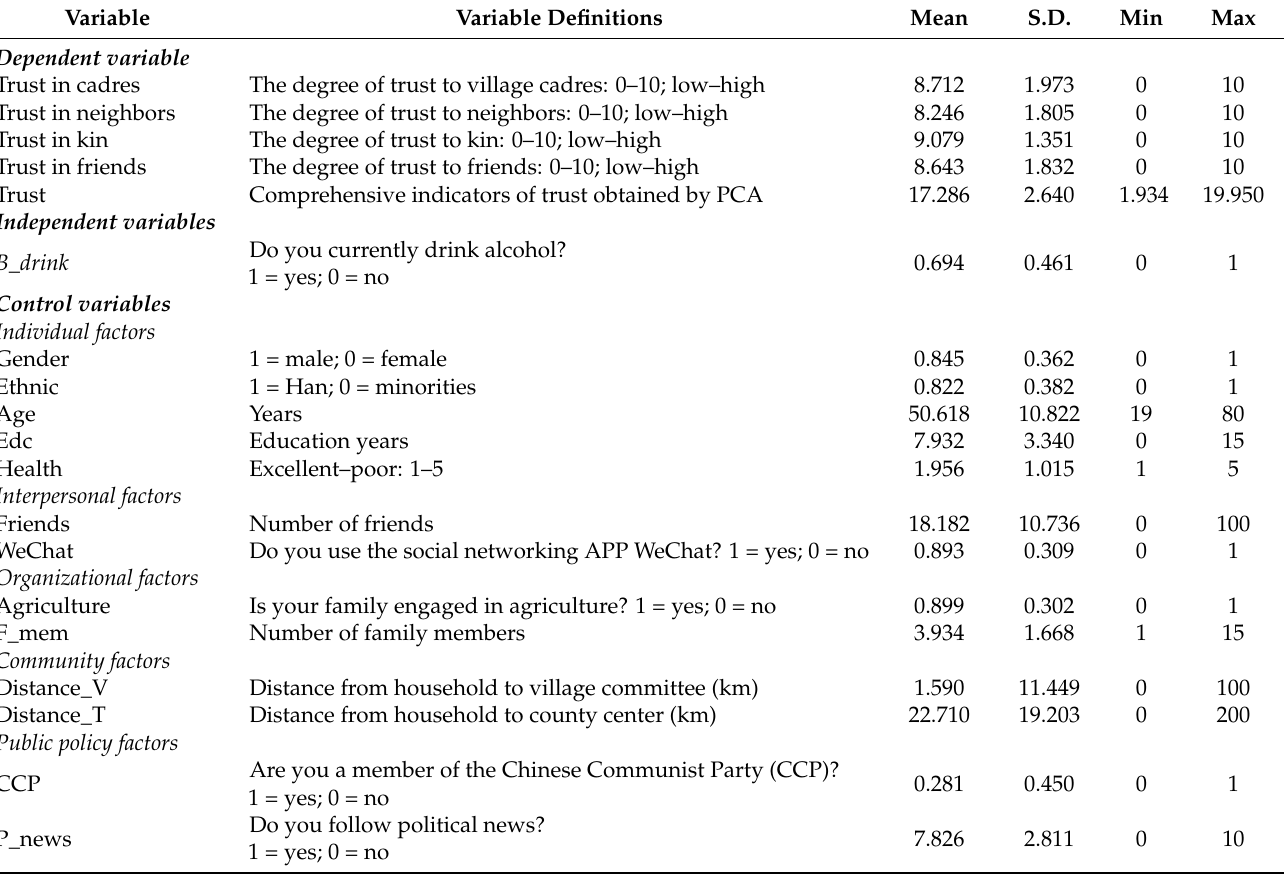
Table 1. Definition and statistics of